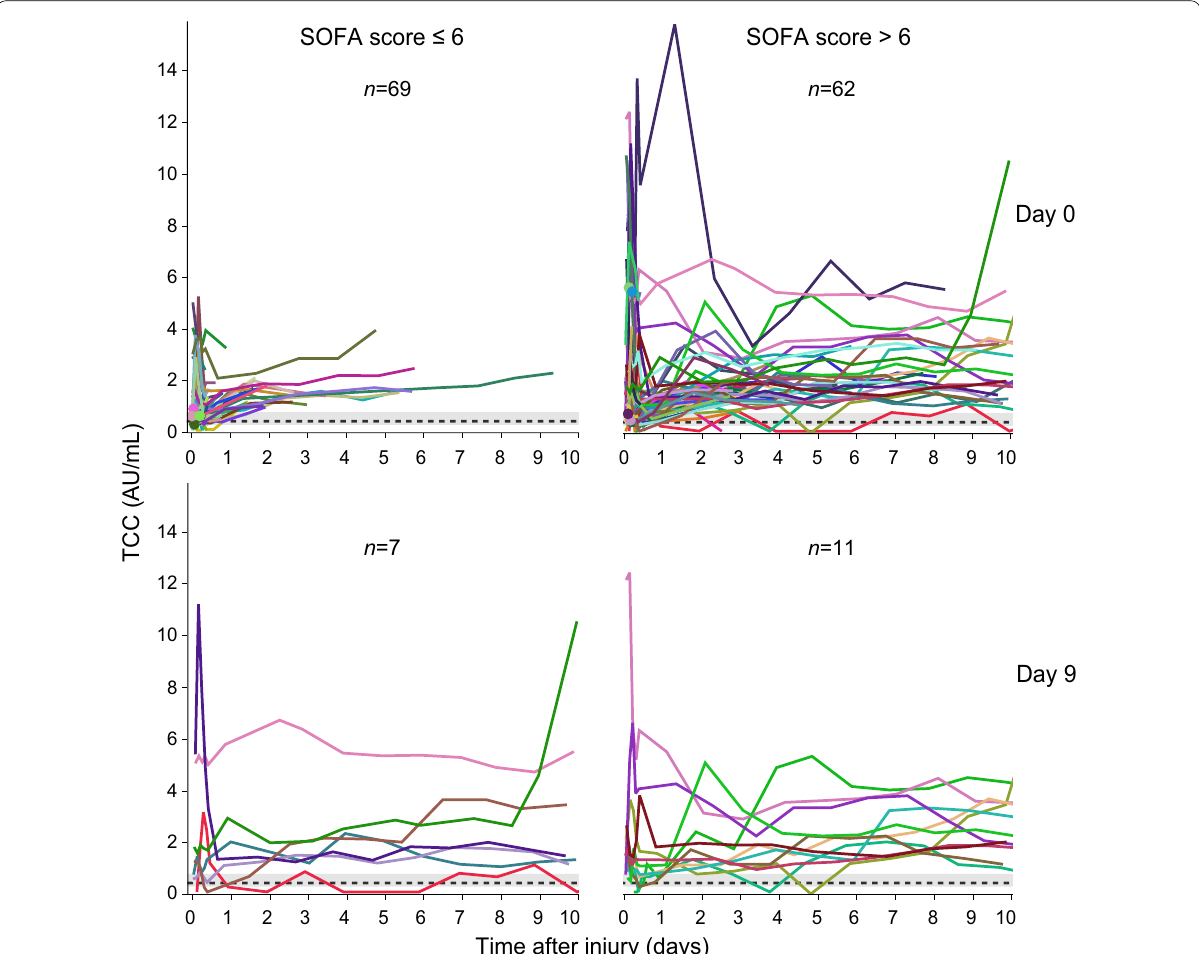
Fig. 5 SOFA score. Total complement complex (TCC) concentration curves for 10 days for patients with low ( Failure Assessment (SOFA) score at day 0 and 9 after trauma. Black dashed lines represent median TCC concentration and grey corresponding areas interquartile ranges for the reference population of 20 healthy